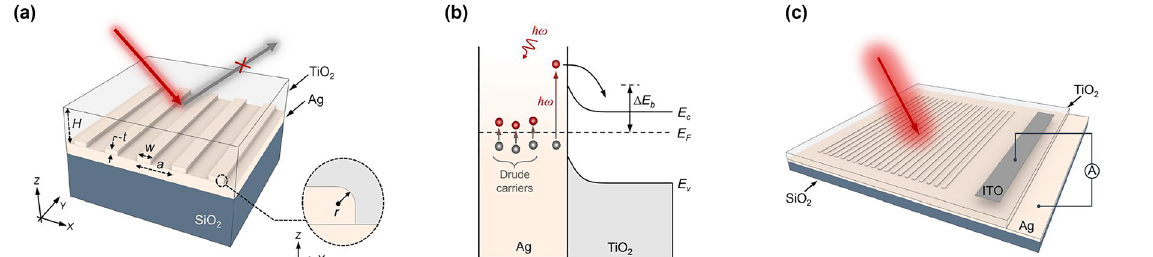
Figure 1: Plasmonic structure for HEPD. (a) Schematic of plasmonic structure supporting perfect absorption enabled by quasi-BIC. The structure comprises a Ag grating (lattice constant a =300 nm)andTiO 2 cladding(thickness H =300nm).Theridgesofthegrating are t =30nmhighand w =120 nmwide.The backAg fi lm is 100 nm thick. Inset shows that the edges of the grating are rounded with a radius r = 6 nm. (b) Mechanisms of the generation and injection of hot electrons at the interface of Ag/TiO 2 . Since the excitation does not extend to the bottom of the metal (left interface), hot electrons are only generated near the interface of Ag/TiO 2 . (c) Schematic of the HEPD integrated with indium tin oxide (ITO) electrodes. The circuit can be formed by wire bonding to the Ag fi lm and